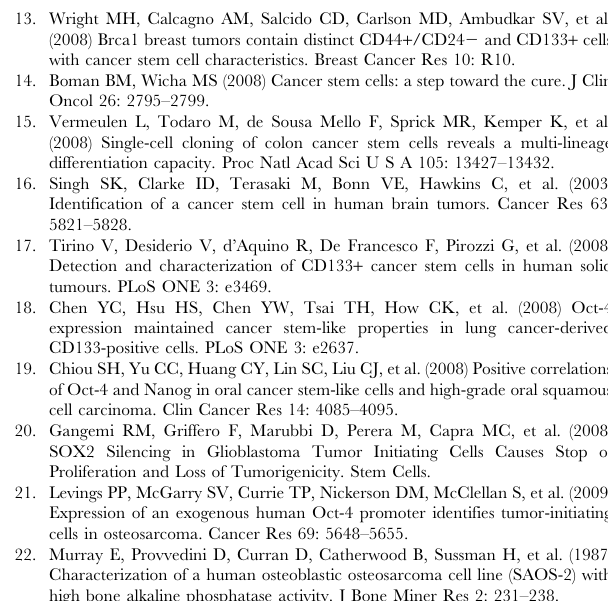
Figure S3 Two-dimensional PAGE analysis of CHA59 monolayer ( top row ) and spheres ( bottom row ) . Vimentin (VIME), translationally controlled tumor protein (TCTP), malate dehydrogenase (MDHM), chromobox protein homolog 3 (CBX3), dihydropyrimidinase-related protein 2 (DPYL2), medium-chain specific acyl-CoA dehydrogenase (ACADM), fructose-bispho- sphate aldolase C (ALDOC).